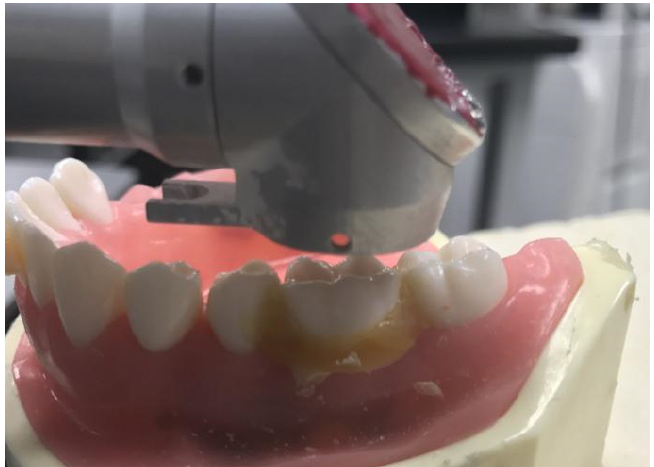
Figure 2. Resin tooth ablated automatically by the dental robot.